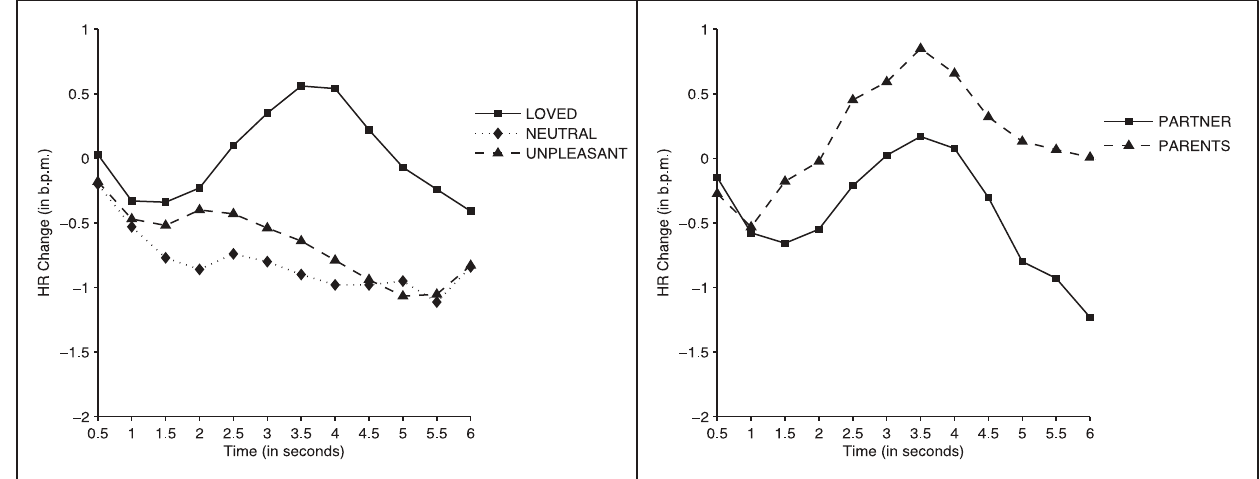
Figure 3. Heart rate response to the faces. Heart-rate changes while participants viewed faces. Left: Loved vs. neutral vs. unpleasant faces. Right: Romantic partner (boyfriend/girlfriend) vs. same-sex parent (father/mother) faces.